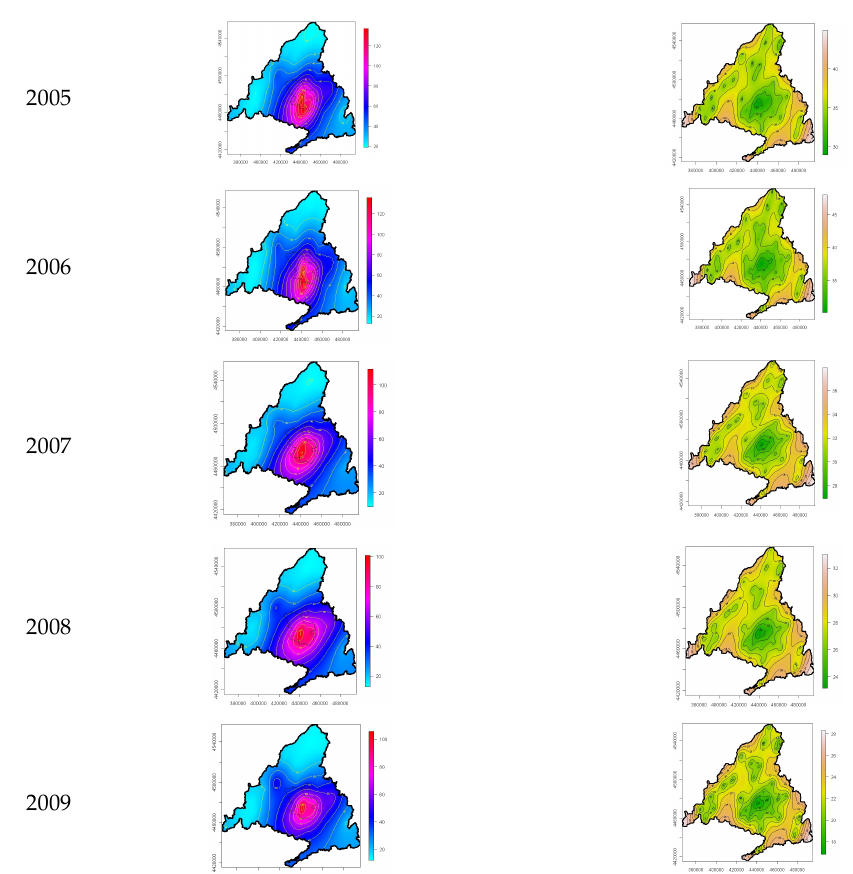
Figure 3. NO x spatio-temporal prediction maps and prediction errors for the 179 municipalities of the Autonomous Community of Madrid, years 2000–2009.